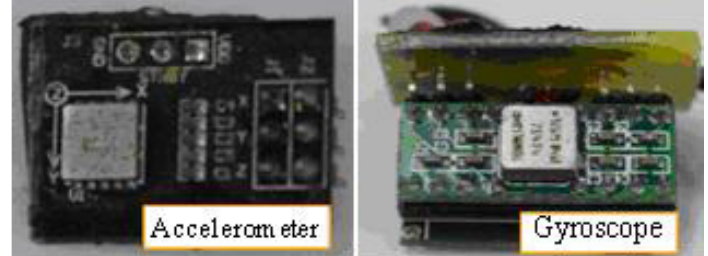
Figure 14. Attitude sensors: ( left ) accelerometer; ( right )